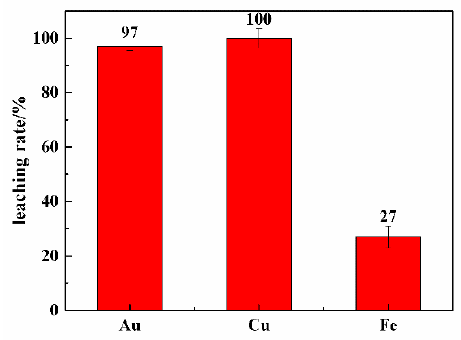
Figure 8. AAS results of TCCA/N 4441 Cl to dissolve gold ore.